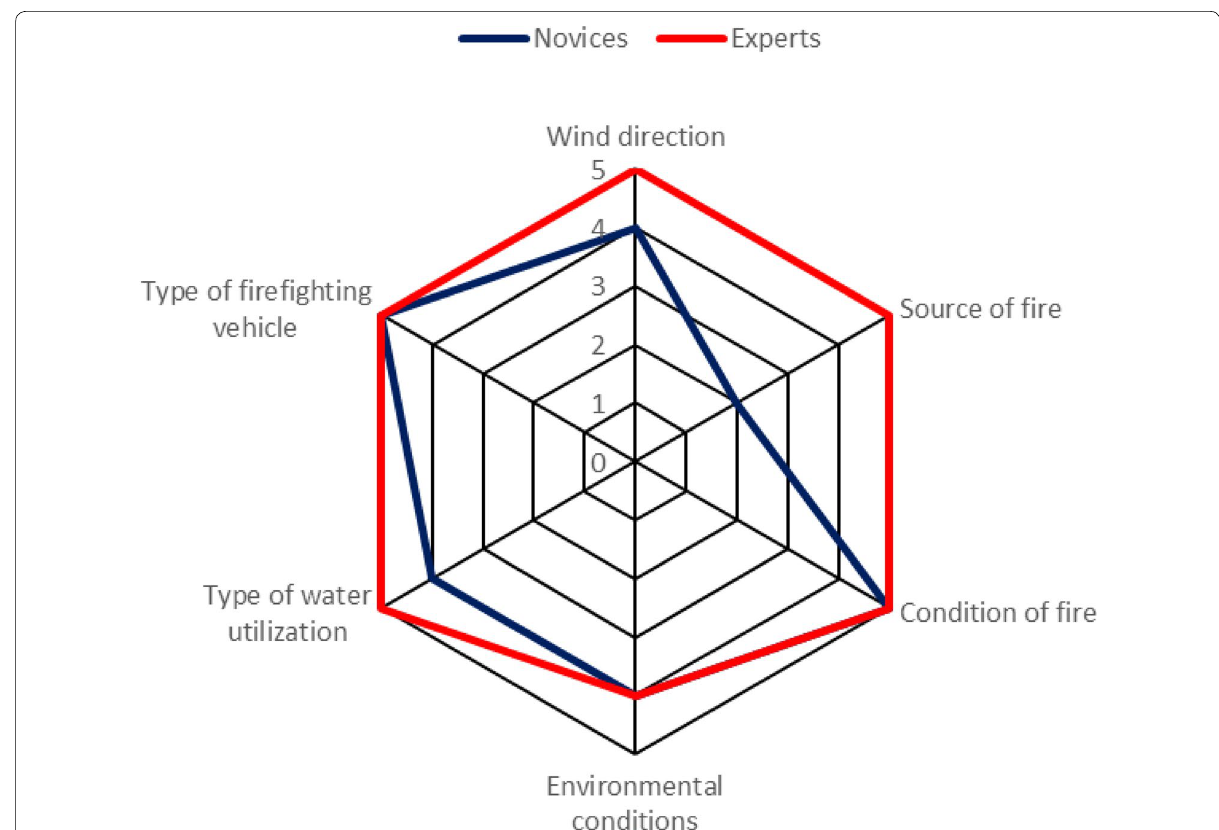
Fig. 13 Comparison of checklist items between novices and experts at decision of the positions of the water